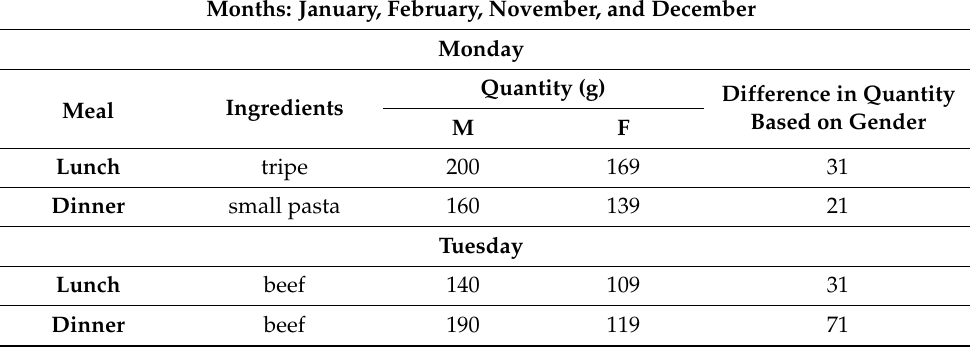
Table 11. Daily quantities of meat and pasta were provided to men and women across the